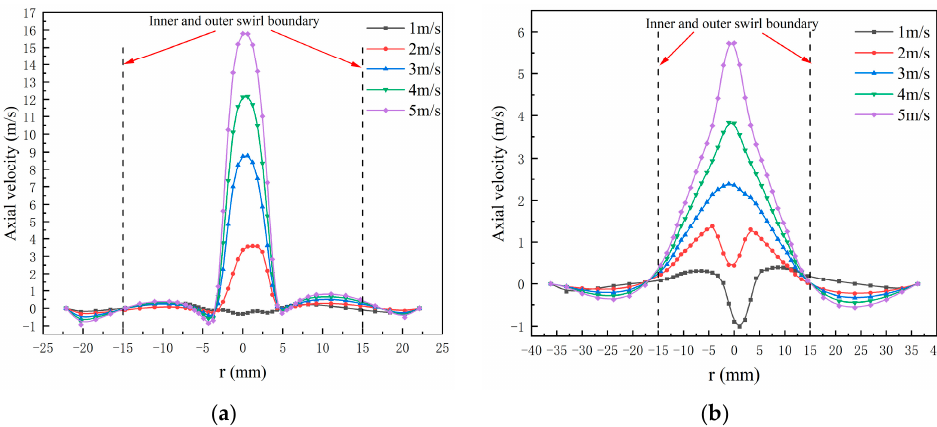
Figure 8. Distributions of the axial velocity. ( a ) z 1 = 90 mm; ( b ) z 2 = 170